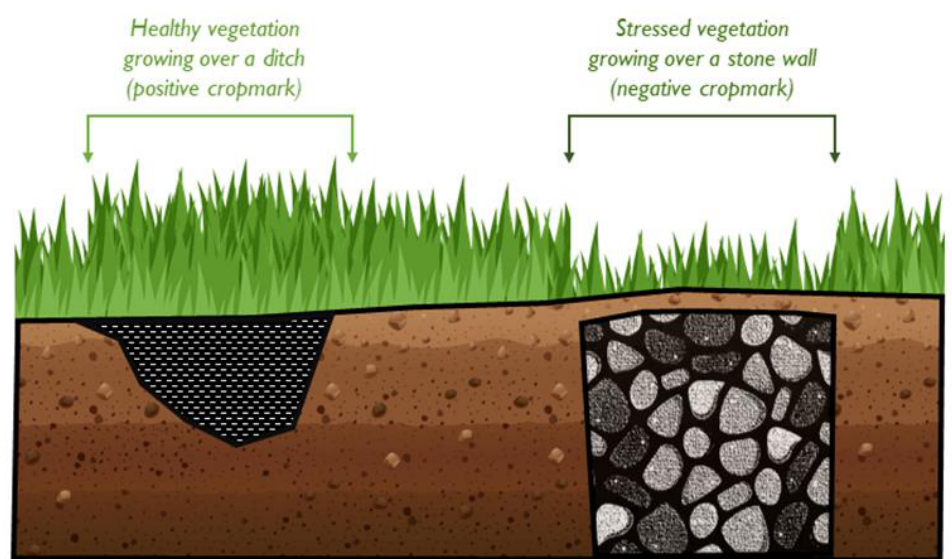
Figure 6. Diagram showing the difference between vegetation growth atop a ditch (healthy) versus a stone wall (stressed).